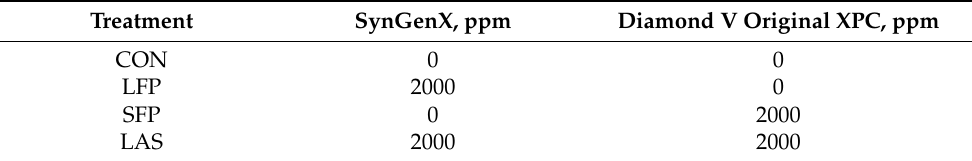
Table 1. A summary of the treatment used in the study.